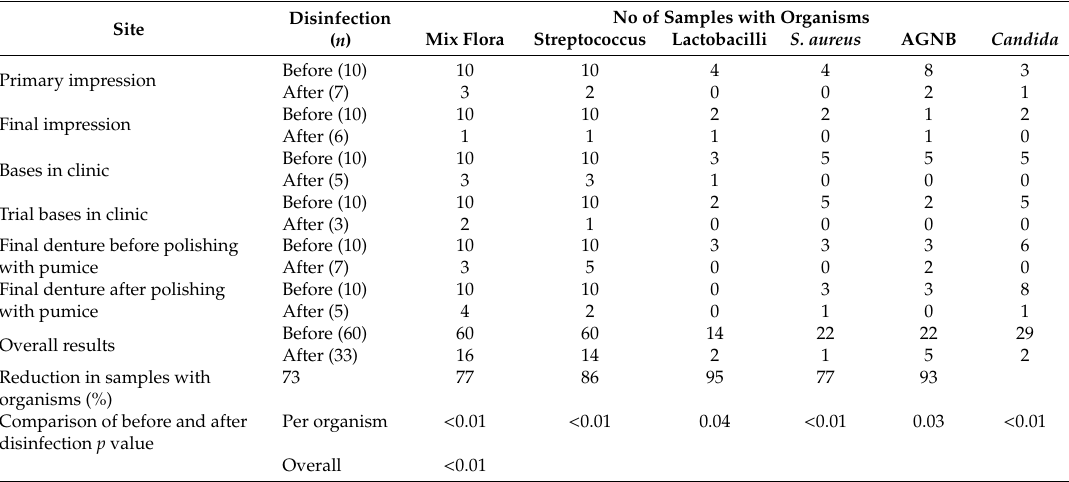
Table 2. E ff ect of disinfection in the prosthetic clinic during the denture fabrication